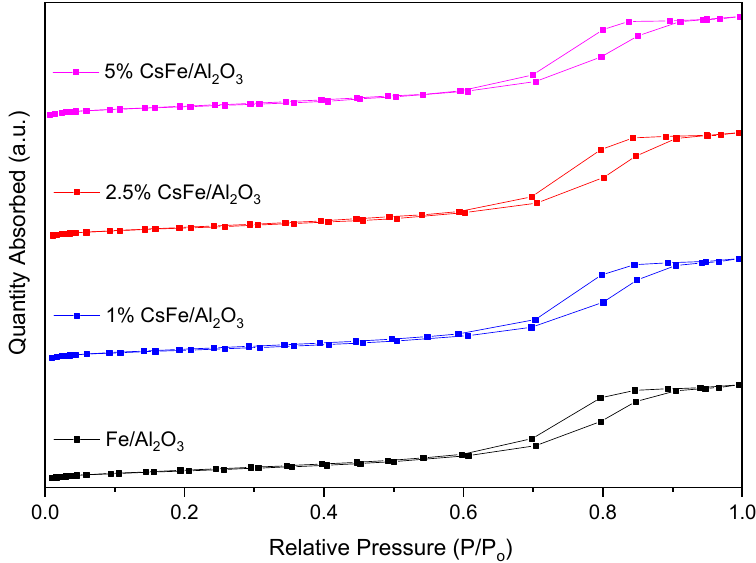
Figure 1. N 2 adsorption-desorption isotherms of the calcined samples.